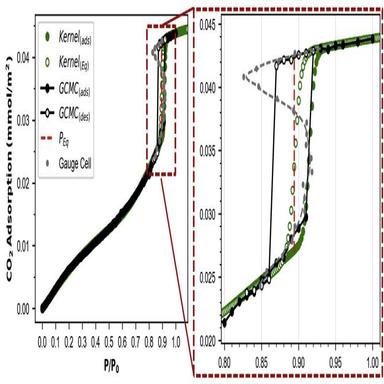
Simulated adsorption isotherm of CO2 in cylindrical carbon pore at 273 K highlighting the differences between equilibrium and adsorption branches. (A colour version of this figure can be viewed online.)